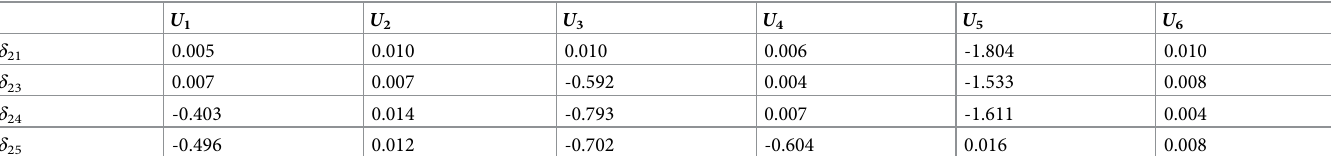
Table 20. The relative dominance of O 2 to